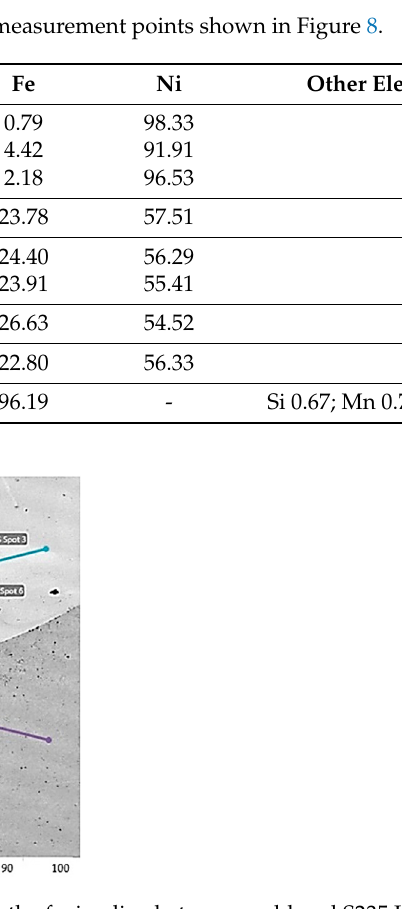
Figure 8. Chemical composition analysis near the fusion line between weld and S235 JR steel. Table 3. Chemical composition, wt.%, in the measurement points shown in Figure 8.